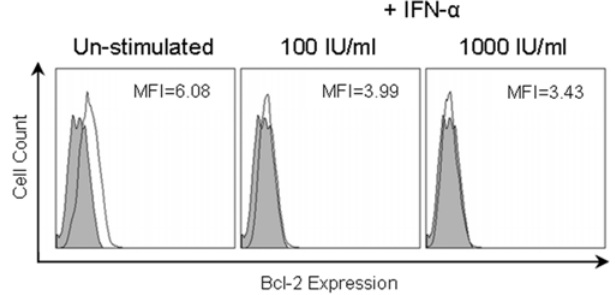
Figure 4. IFN- treatment does not induce Bcl-2 expression. Hepatocyte expression of the anti-apoptotic protein Bcl-2 was assessed by FACS. HHL-17 cells were stimulated with IFN- a at either 0 IU/ml, 100 IU/ml or 1000 IU/ml for 16 hours. Un-stimulated hepatocytes expressed low levels of Bcl-2 (MFI of 6.08), while those treated with either 100 IU/ml or 1000 IU/ml of IFN- a lost expression (MFI of 3.99 and 3.42 respectively); filled curves represent an isotype control, and solid lines represent the Bcl 2 staining.